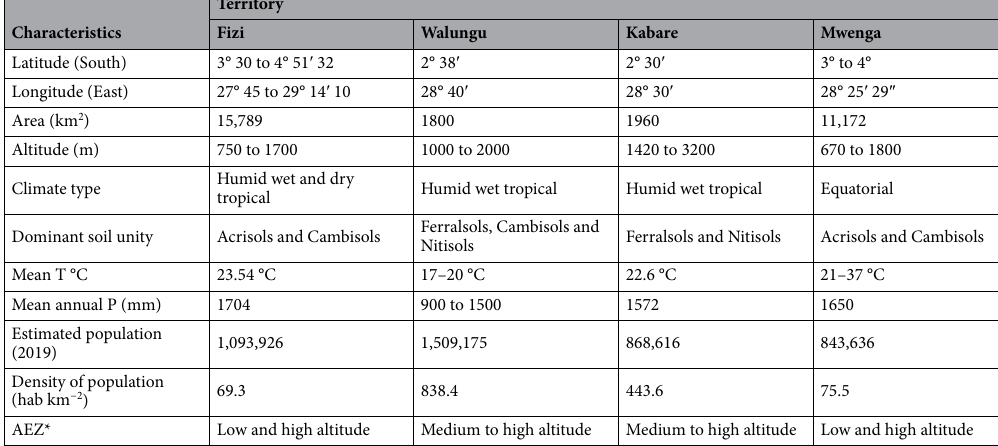
Table 1. Agro-ecological conditions of the study area (retrieved from CAID). P (mm) Precipitation (rainfall), AEZ Agro-Ecological Zone (High, Medium,